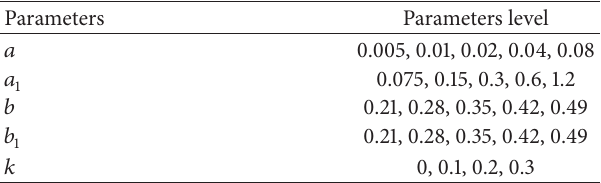
Table 2: Parameters and parameter level settings.